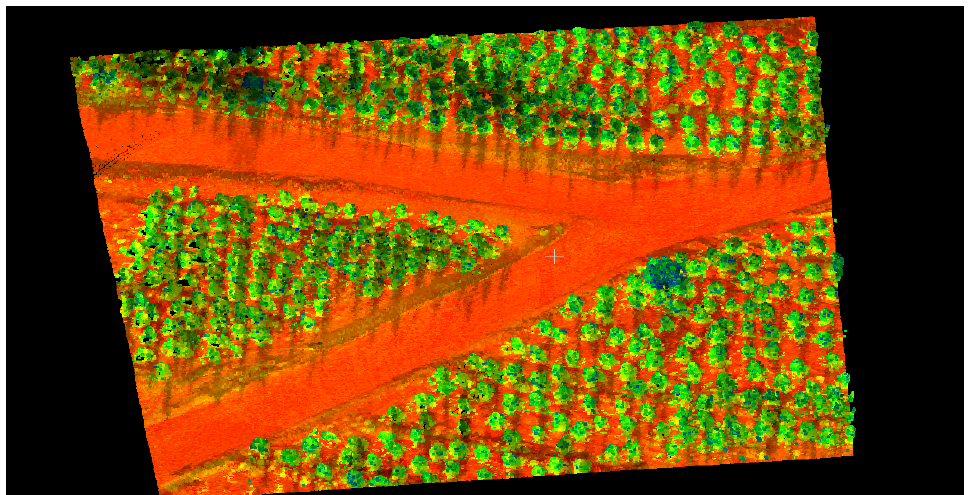
Figure 17. Adding colors to the datasets of Figure